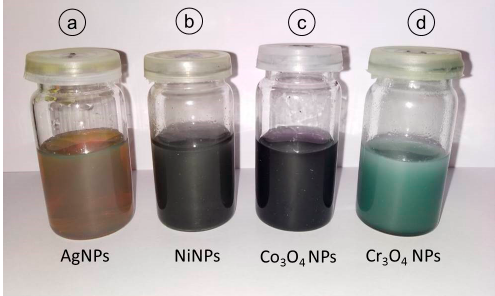
Figure 2. Pictures of synthesized colloidal samples showing the colors of final stage of solutions in each case. Different colors depict different composition of NPs.